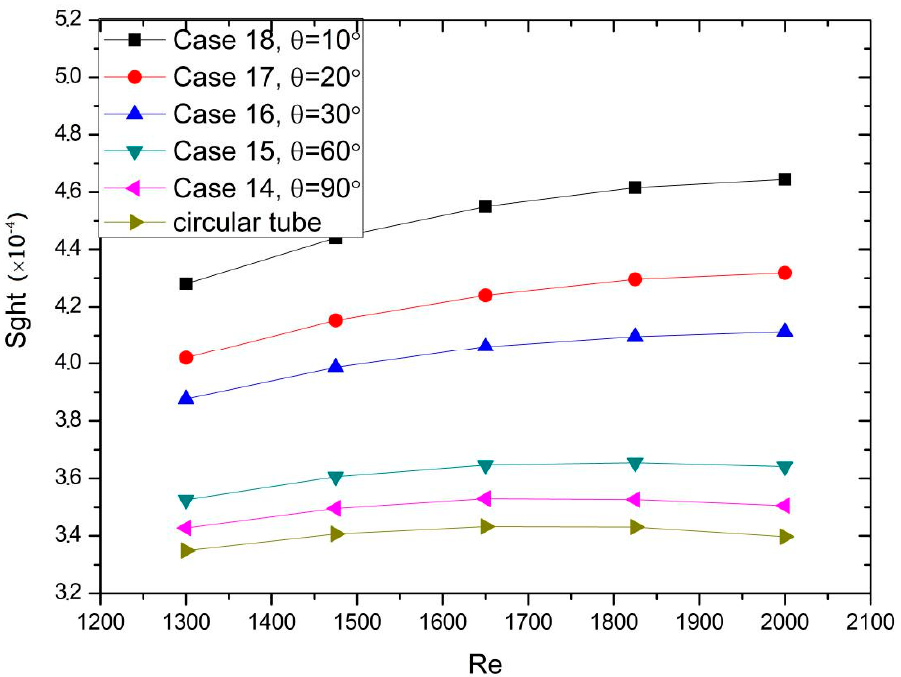
Figure 13. E ff ect of di ff erent angle on Sght at di ff erent Reynolds numbers. Figure 13. Effect of different angle on Sght at different Reynolds numbers.